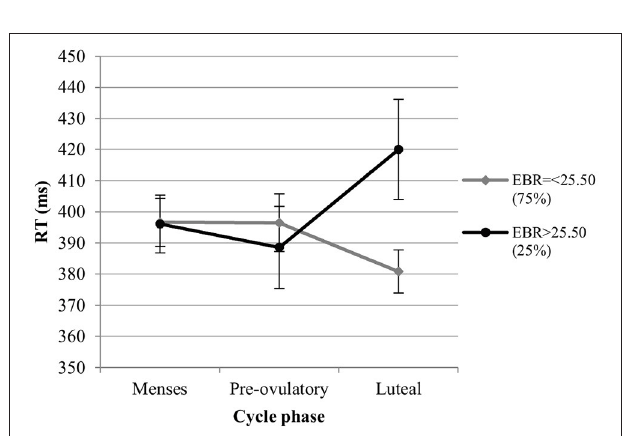
FIGURE 7 | Interactive effects of cycle phase and EBR on reaction time (RT) for Stroop color. Responses were slower in the luteal phase compare to menses and pre-ovulatory phase for women with higher EBR during menses and faster in the luteal phase compare to the menses and pre-ovulatory phase for women with lower EBR during